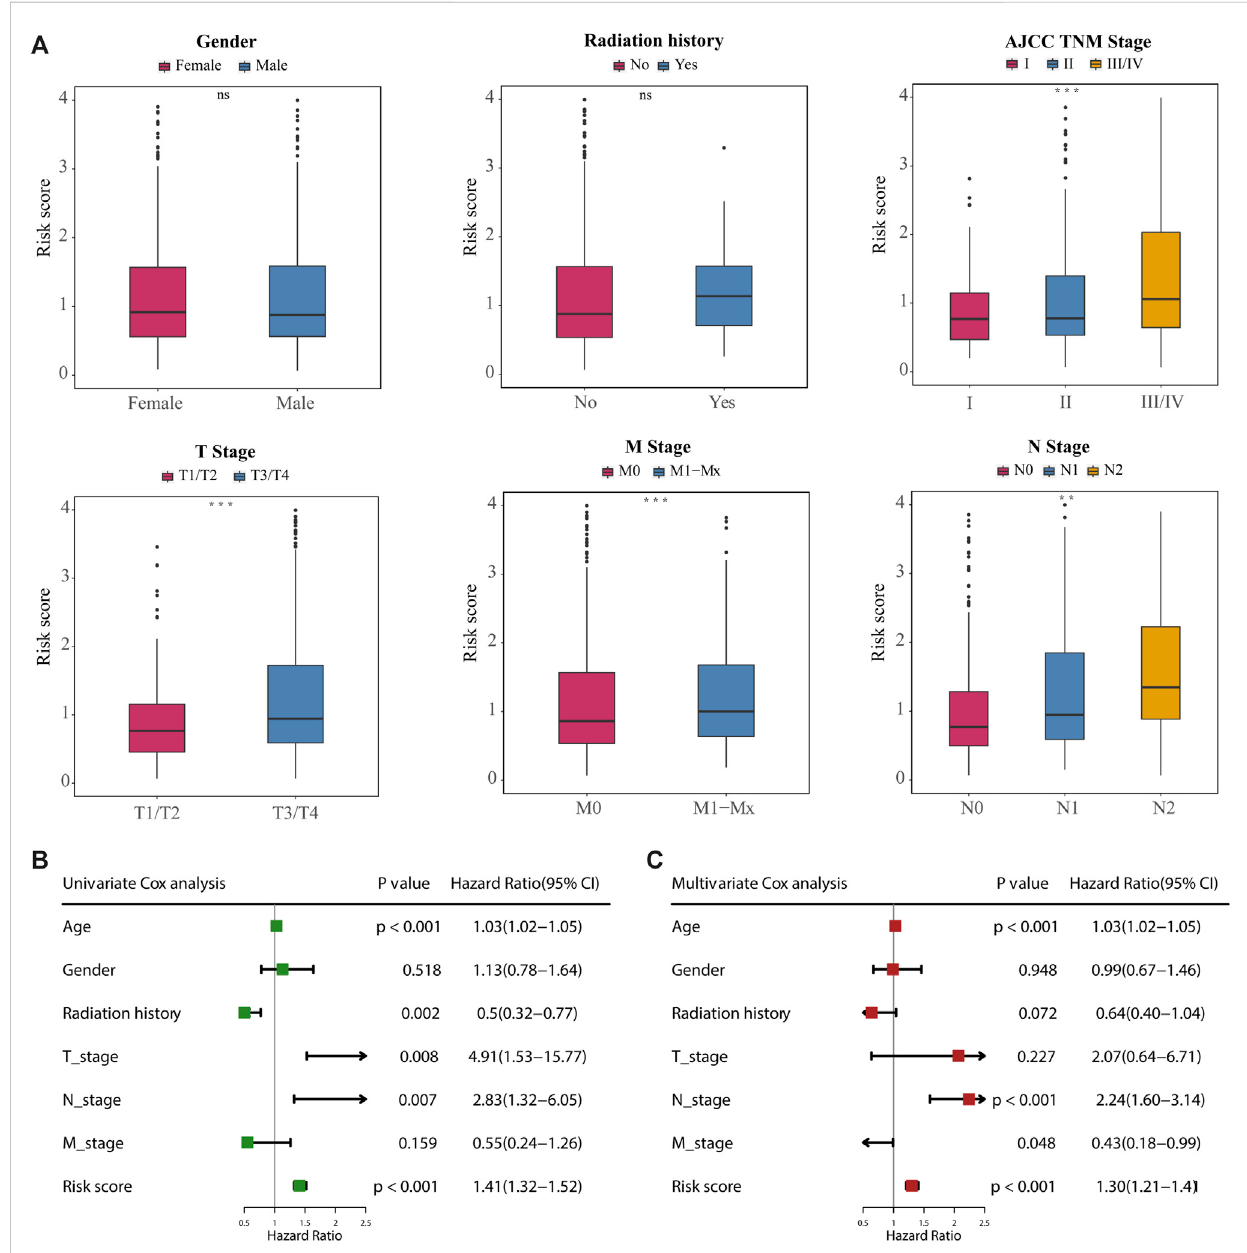
FIGURE 6 Correlation between the 18-gene expression signatures and clinical characteristics. (A) Difference analysis of the distribution of risk scores in different T, N, M, AJCC TNM stages, gender, and radiation history. Statistical difference of two groups was compared by the Wilcoxon test and three or more groups were compared by the Kruskal – Wallis test (* p < 0.05; ** p < 0.01; *** p < 0.001; ns not signi fi cant). (B, C) Univariate (B) and multivariate (C) Cox regression analyses of correlations between the 18-gene expression signatures and clinical characteristics with OS, and revealed that the risk score based on the m6A-related gene expression signatures was an independent prognostic predictor in the TCGA